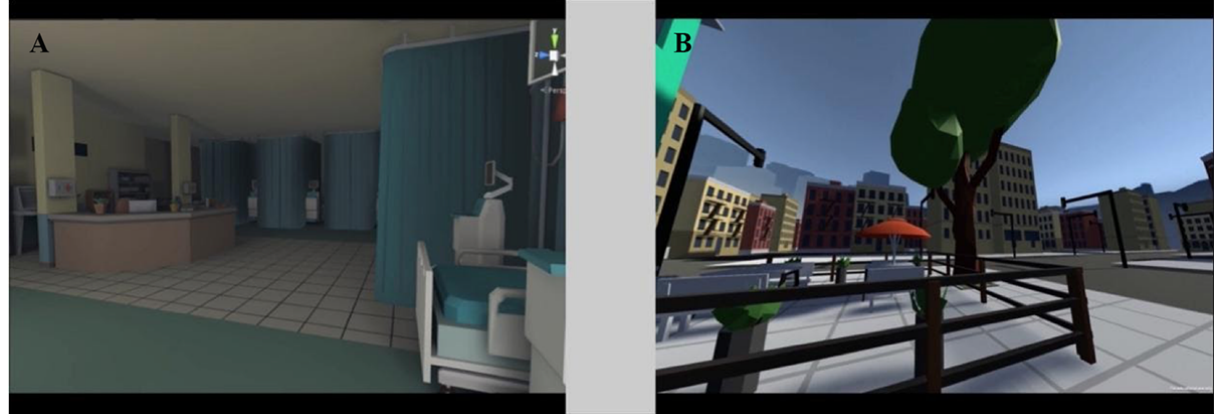
Figure 1. Screenshots of mobile 360°